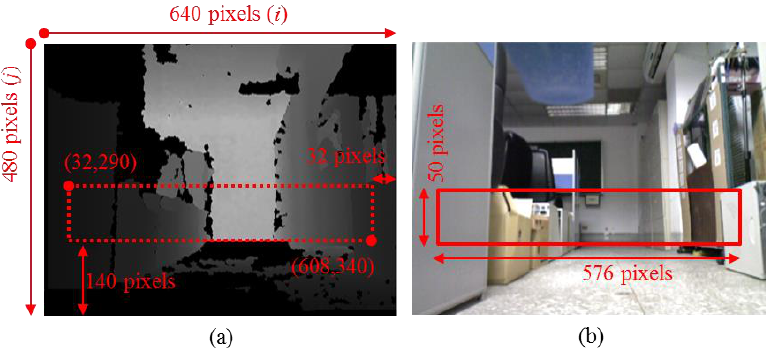
Figure 5. The region of interest (ROI) of ( a ) depth information and ( b ) color image of the SVS.